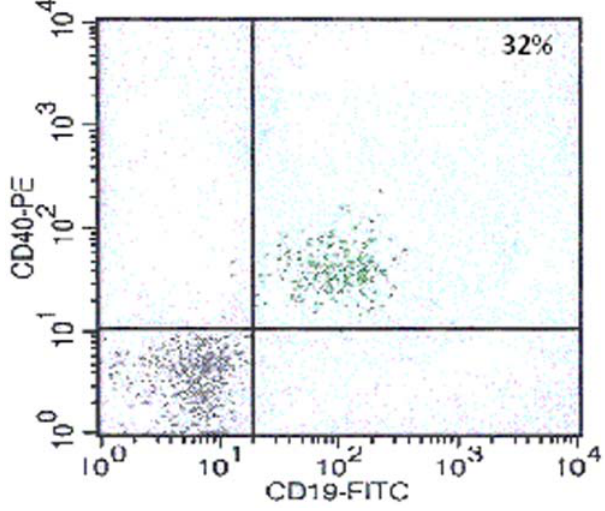
Figure 2. Results of CSF analysis by flow cytometry in a HAT patient with a cell count of 63 cells/ m l.